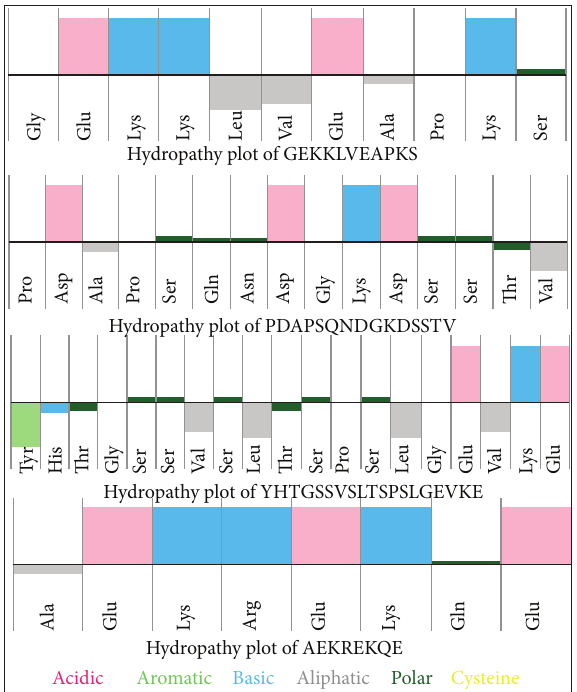
Figure 9: Hydropathy plot of GEKKLVEAPKS, PDAPSQNDGKDSSTV, YHTGSSVSLTSPSLGEVKE, and AEKREKQE. Composition of amino acid in a peptide is represented in coloured format showing top region as hydrophilic and bottom region as hydrophobic.